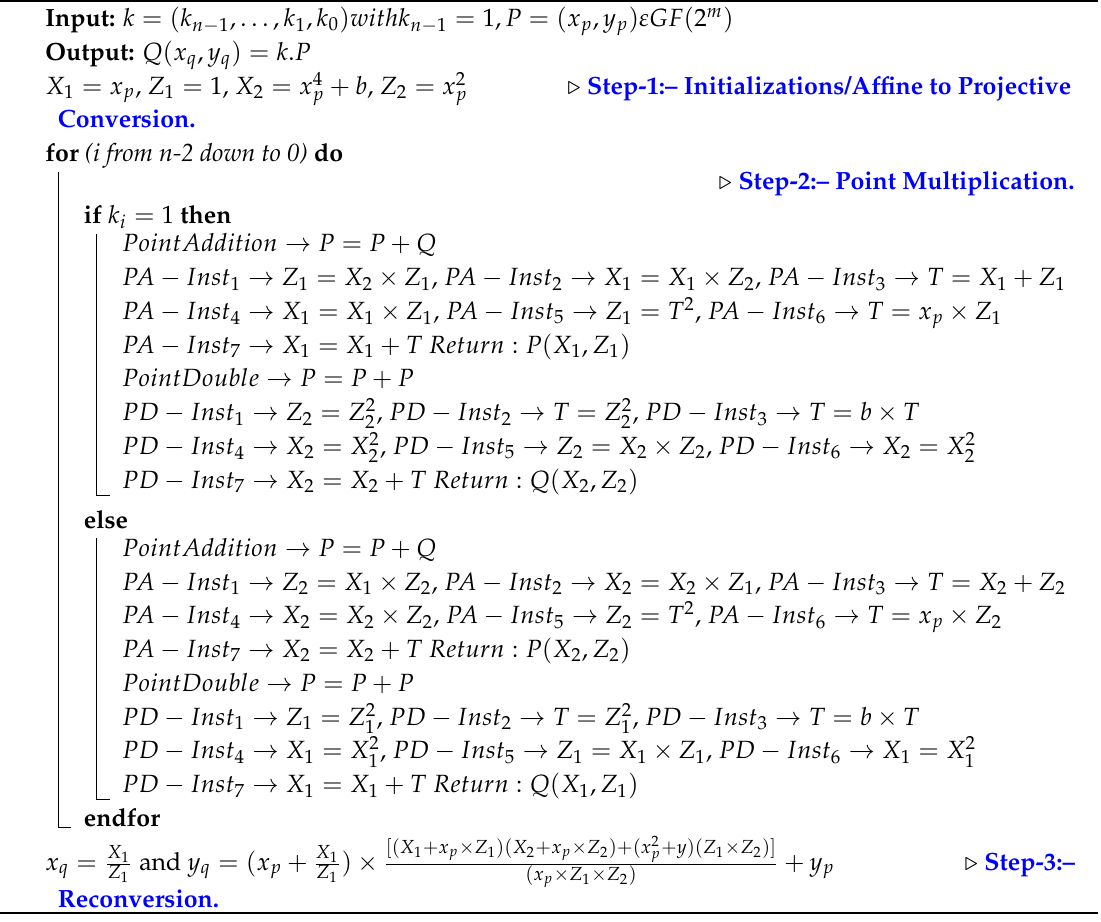
Algorithm 1: Montgomery point multiplication algorithm